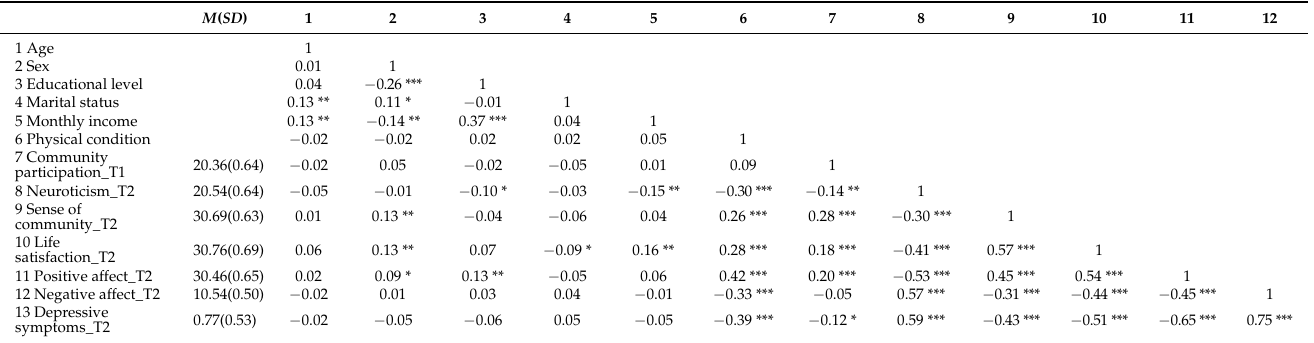
Table 2. Inter-correlations between main